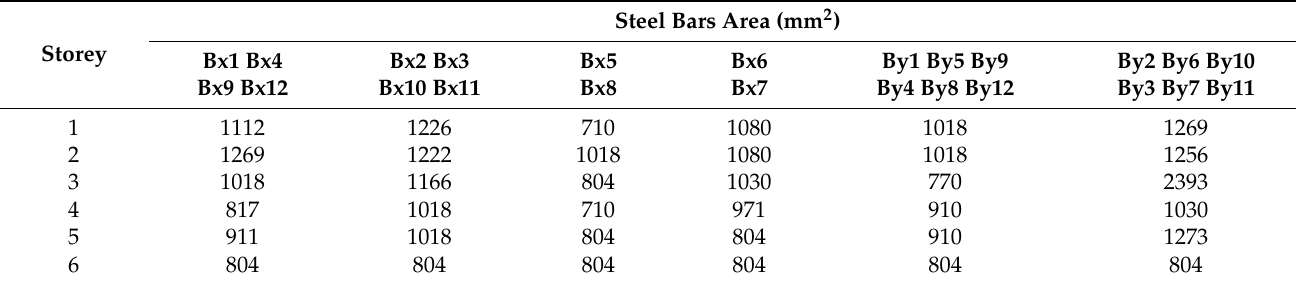
Table 2. Sizes and reinforcement details of frame beams.